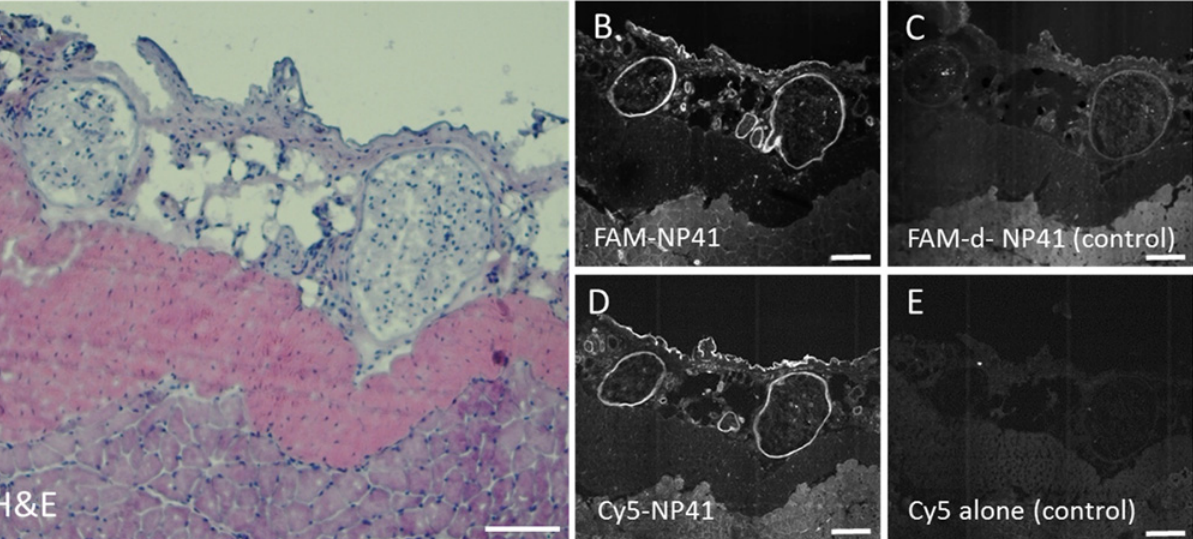
Fig 3. Confocal microscopic imaging of degenerated nerve sections after topical application of F-NP41 and control peptide. A . H&E stained sample of two degenerated facial nerve branches excised 10 weeks after main branch transection. B. Confocal fluorescence microscopy image after topical F-NP41 application of the same sample shows specific fluorescent labeling of the epineurium and perineurium of the degenerated nerve branches, while topical application of FAM-d-NP41 in C , serving as a control, shows no specific labeling. D. Section of the same tissue sample stained with Cy5-NP41 also shows fluorescent labeling of the degenerated branches, while application of free Cy5 in E show no specific labeling. Images B through E brightened 40%, scale bars 100 μ m.